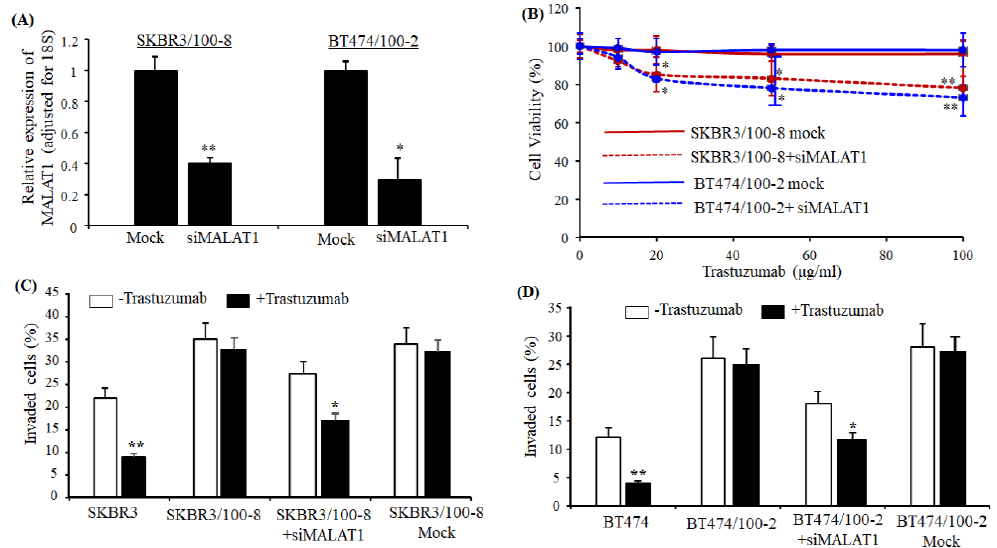
Figure 2. Knockdown of MALAT1 increases HER2-cells sensitivity of trastuzumab . ( A ). SKBR3/100-8 and BT474/100-2 cells were treated with siRNA MALAT1 or negative sequences (mock) for 72 h as described in Methods, and RNA extracted. The bar graphs indicate the relative levels of MALAT1 (mean ± SEM) as determined by RT-qPCR from four repeated experiments and show MALAT1 knockdown cells have downregulated MALAT1, * p < 0.05 , and ** p < 0.01 compared to mock cell lines. The ANOVA test determined the significance; ( B ). SKBR3/100-8 and BT474/100-2 treated with